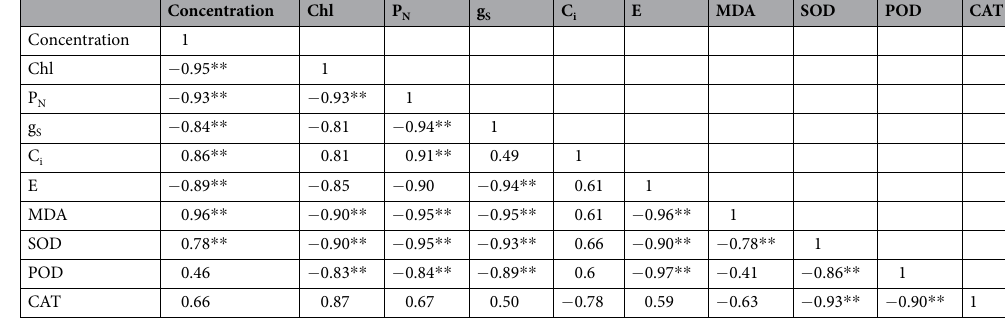
Table 1. Coefficients of correlation ( r 2 ) among concentration, photosynthetic traits and antioxidant attributes of Lycium barbarum grown under various NaCl and NaHCO 3 concentrations. Abbreviations: Chl: chlorophyll, P N : net photosynthetic rate, g S : stomatal conductance, E: transpiration rate, C i : intercellular CO 2 concentration, MDA: malondialdehyde, SOD: superoxide dismutase, POD: peroxidase, CAT: catalase. ** Significant correlation (P < 0.01, n = 20).